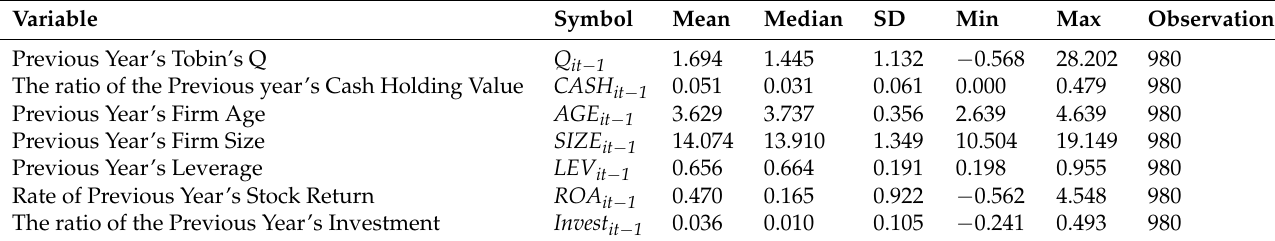
Table 4. Descriptive statistics of the investment efficiency